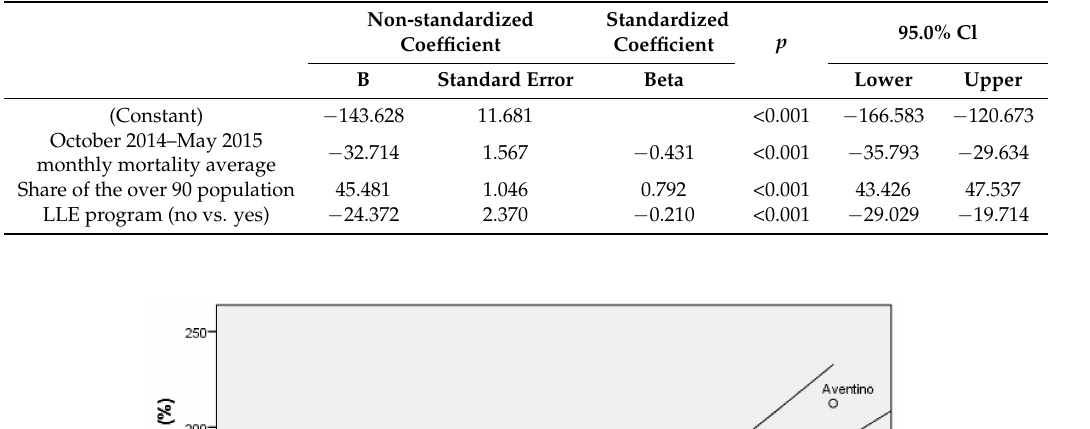
Table 3. Multivariable linear regression: dependent variable: 2014–2015 summer mortality increase; weighted for the summer of 2015 mean population size, adjusted for the share of the over 90 population and the October 2014–May 2015 monthly mortality average; R 2 = 0.789.